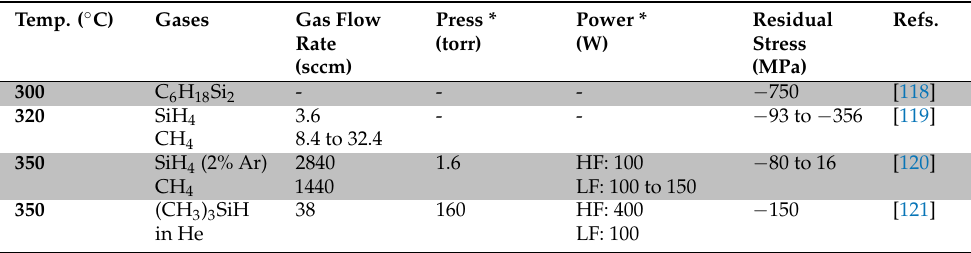
Table 11. Reported Residual Stresses of PECVD Silicon Carbide as a Function of Processing Conditions. Temp. ( ◦